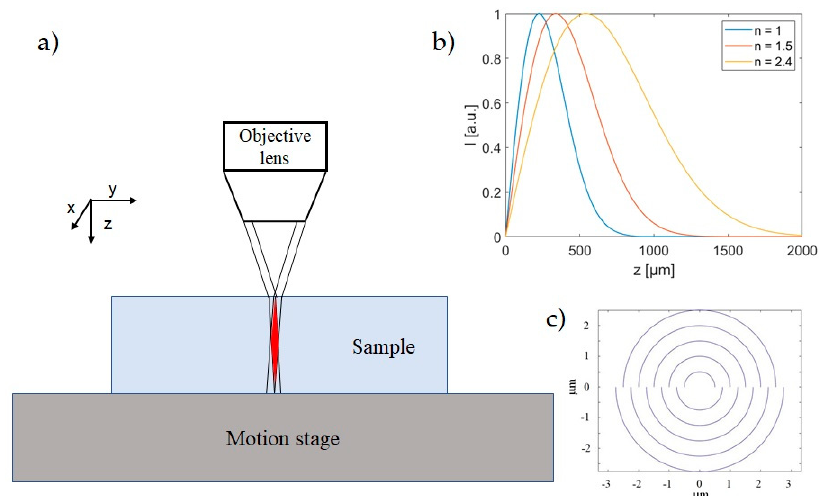
Figure 1. ( a ) Scheme of the relative positioning of the Bessel beam with respect to the sample (the Bessel zone is shown in red) for an optimal energy deposition along the whole sample thickness during the laser machining [18]. Note that here, just for illustration, the Bessel zone is arbitrarily represented with a length equal to the sample thickness; ( b ) normalized intensity profiles of a Bessel beam with cone angle 12° calculated in three different media (air, borosilicate glass and diamond respectively); ( c ) schematic example of spiraling trajectories programmed with SCA for the hole drilling.